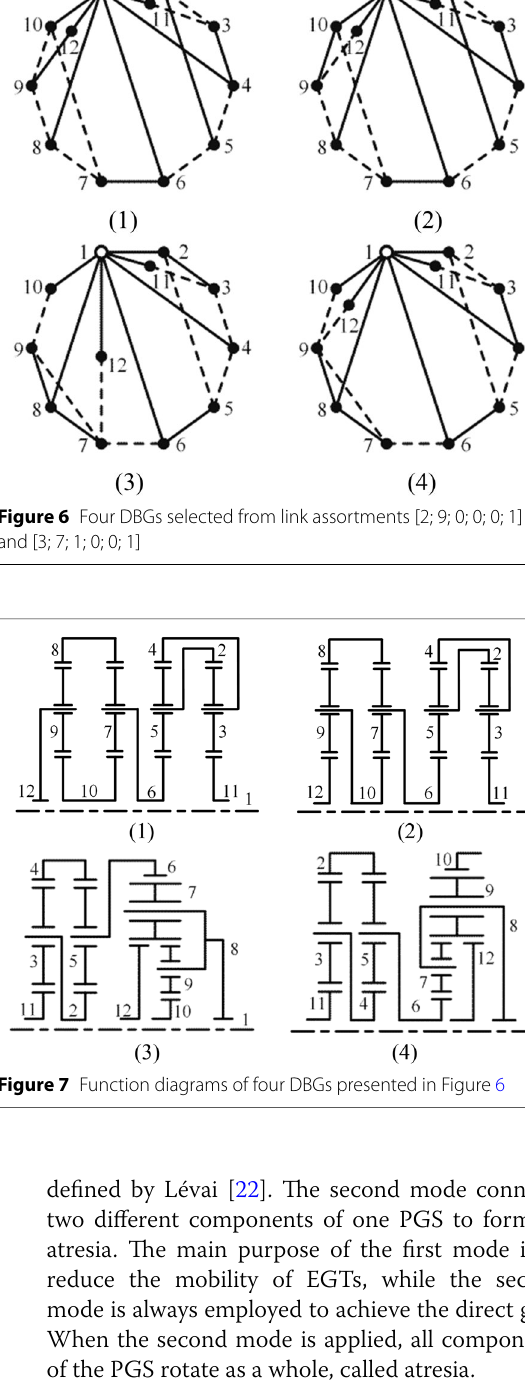
defined by Lévai [22]. The second mode connects two different components of one PGS to form an atresia. The main purpose of the first mode is to reduce the mobility of EGTs, while the second mode is always employed to achieve the direct gear. When the second mode is applied, all components of the PGS rotate as a whole, called atresia. (5) Determine the position of brakes. Brakes cannot be added on input member and output member.